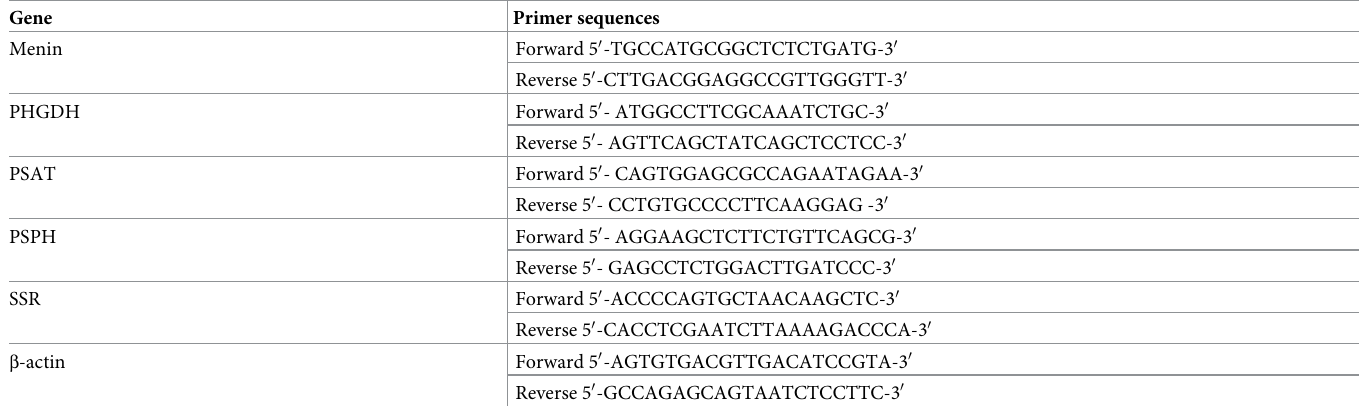
Table 2. Primer sequences used in this study.